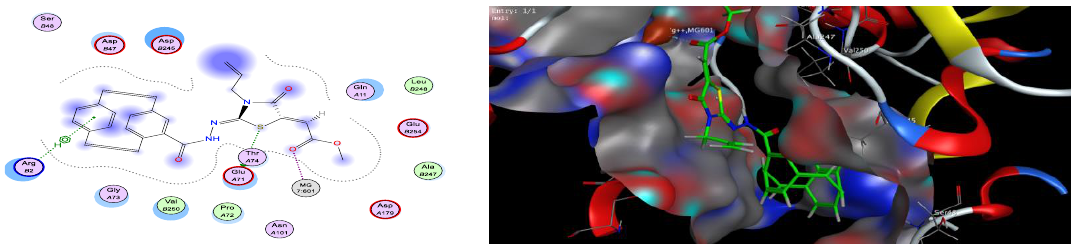
binding site of β-tubulin.